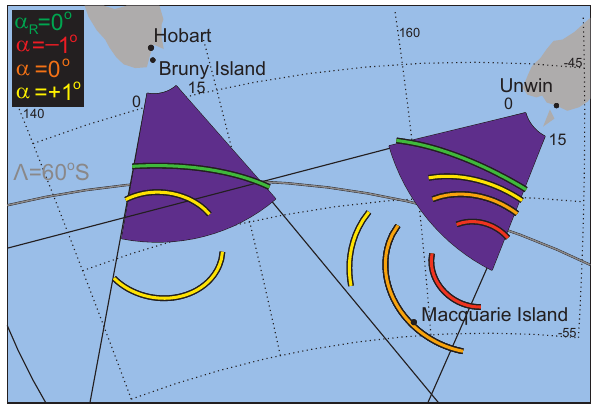
Fig. 1. The positions and the near fields-of-view (FoVs) of the TIGER Bruny Island and Unwin radars. Beam 0 (15) is the western- most (easternmost) beam of each radar as labelled on the diagram. The short-range part of the FoV (180–765km) where the E-region backscatter is expected is shown in dark blue for each radar. Also shown are the positions of two ionosondes at Hobart and on Mac- quarie Island. The curved grey line is the line of constant magnetic latitude 3 = 60 ◦ S. The lines of constant geometric aspect angle at 110km, α =− 1 ◦ , 0 ◦ and + 1 ◦ , are shown by the red, orange and yel- low circular lines, respectively. The green lines represent the model real aspect angle lines α R = 0 ◦ at 110km calculated using a peak electron density of 4 × 10 4 cm − 3 (see text for